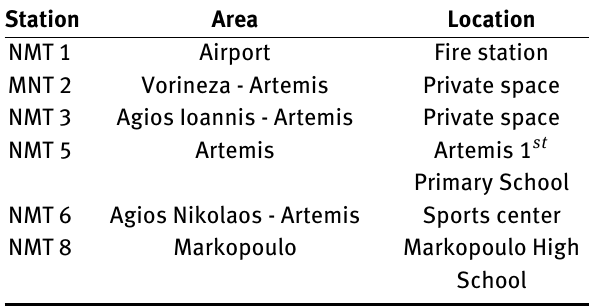
Table 1: Noise monitoring system of AIA